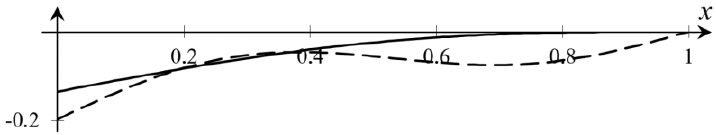
Figure 6. Graphs of 𝑄˙ 1 (𝑥, 6) (solid line) and 𝑄˙ 2 (𝑥, 6) (dashed line).